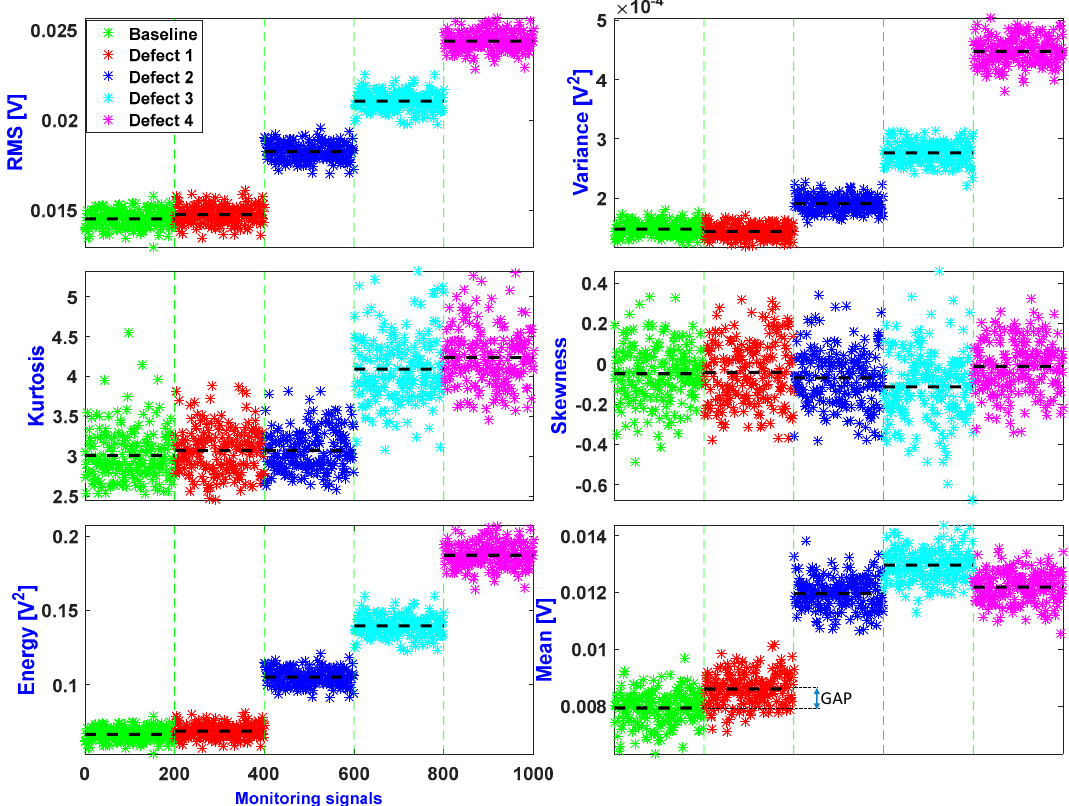
Figure 11. Results of the features extracted from the corrupted signals. RMS: root mean square.